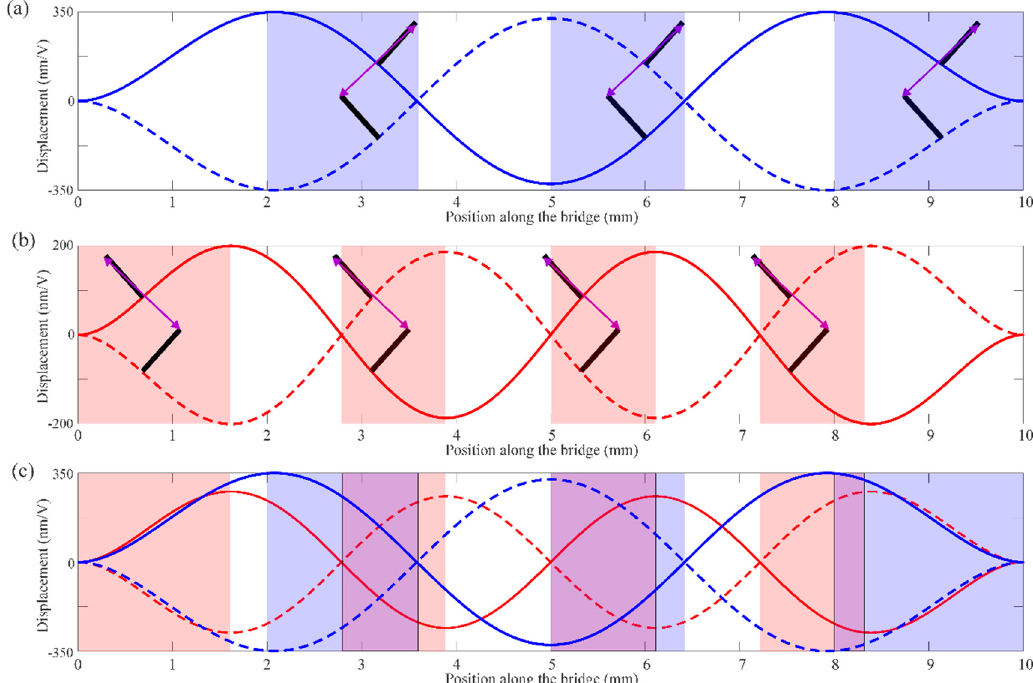
Figure 4. Operation principle of the SW-driven motor and leg position design. Maximum (solid line) and minimum (dashed line) deformation of the standing waves for ( a ) the (4,0) mode with legs on the right side of the crests (blue area) for forward direction slider motion and ( b ) the (5,0) mode with legs on the left side of the crests (red area) for backward direction slider motion. Double head purple arrow indicates the trajectory of the leg tip. ( c ) Overlapped area where legs could be placed for bidirectional motion of the slider.